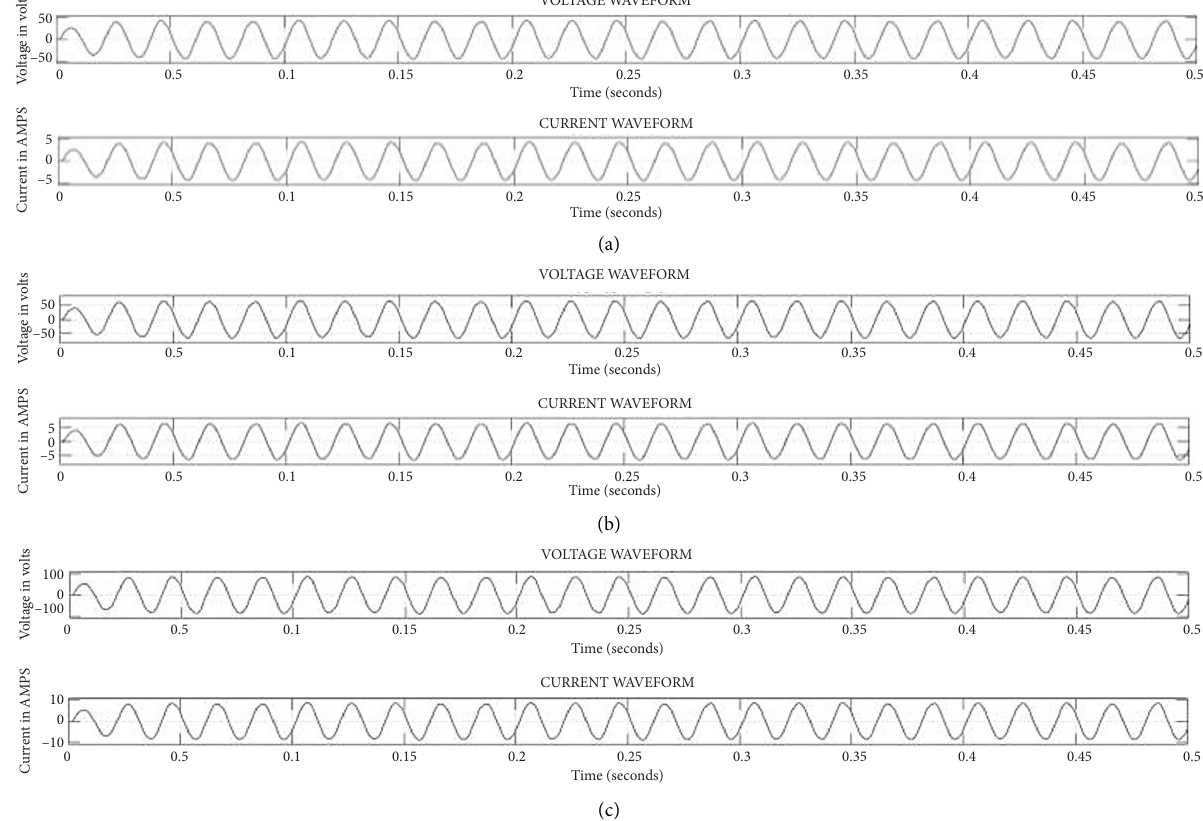
Figure 15: Output waveforms [16]. (a) Output waveforms for 50 V input. (b) Output waveforms for 75 V input. (c) Output waveforms for 100V